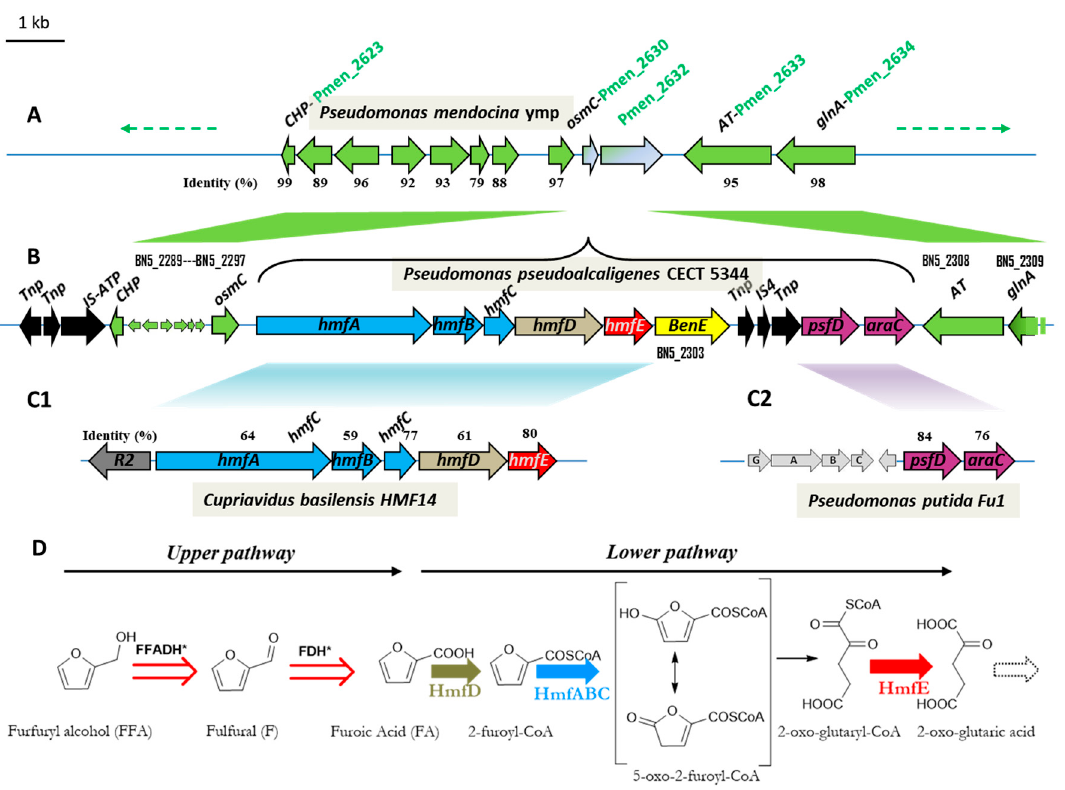
Figure 1. Scheme of the genetic organization of the hmf operon ( A – C ) (adapted from Ref. [9]) and predicted metabolic pathway for the assimilation of furfuryl alcohol in Pseudomonas pseudoalcaligenes ( D ). The hmf locus in P. pseudoalcaligenes CECT 5344 (delimited by a curly bracket, B ) is located between BN5_2297 ( osmC ) and BN5_2308 ( AT ). The corresponding homologous genes in Pseudomonas mendocina ymp ( Pmen_2630-2633 ) are consecutive in its genome ( A ) and the syntney of the homologous genes is conserved both upstream and downstream the hmf locus (green arrows). The hmf locus contains genes homologous to that described in the context of furfural degradation in Cupriavidus basilensis [24] ( C1 ) and in Pesudomonas putida [25] ( C2 ). The black arrows (panel B ) represent genes involved in the transposition of mobile genetic elements. ( D ) Proposed pathway for the assimilation of FFA in P. pseudoalcaligenes R1. FFADH and FDH are furfuryl alcohol and furfural dehydrogenase, respectively. * FFADH and FDH could be the same enzyme, whose coding genes are unknown in P. pseudoalcaligenes . Both the oxidation of FFA and HMF in C. basilensis (not shown) converge in FA constituting the upper pathway. The lower pathway, encoded by the hmfABCDE operon ( C1 ), is a series of reactions transforming FA into 2-oxo-glutaric acid. HmfA is a furoyl-CoA synthetase and HmfABC a furoyl CoA dehydrogenase. The transformation of 5-oxo-2-furoyl-CoA into 2-oxo-glutaril-CoA has no assigned gene and can be a spontaneous reaction or could be catalysed by an unspecific lactone hydrolase. Finally, HmfE was proposed to be the thioesterase rendering 2-oxo-glutaric acid from 2-oxo-glutaryl CoA